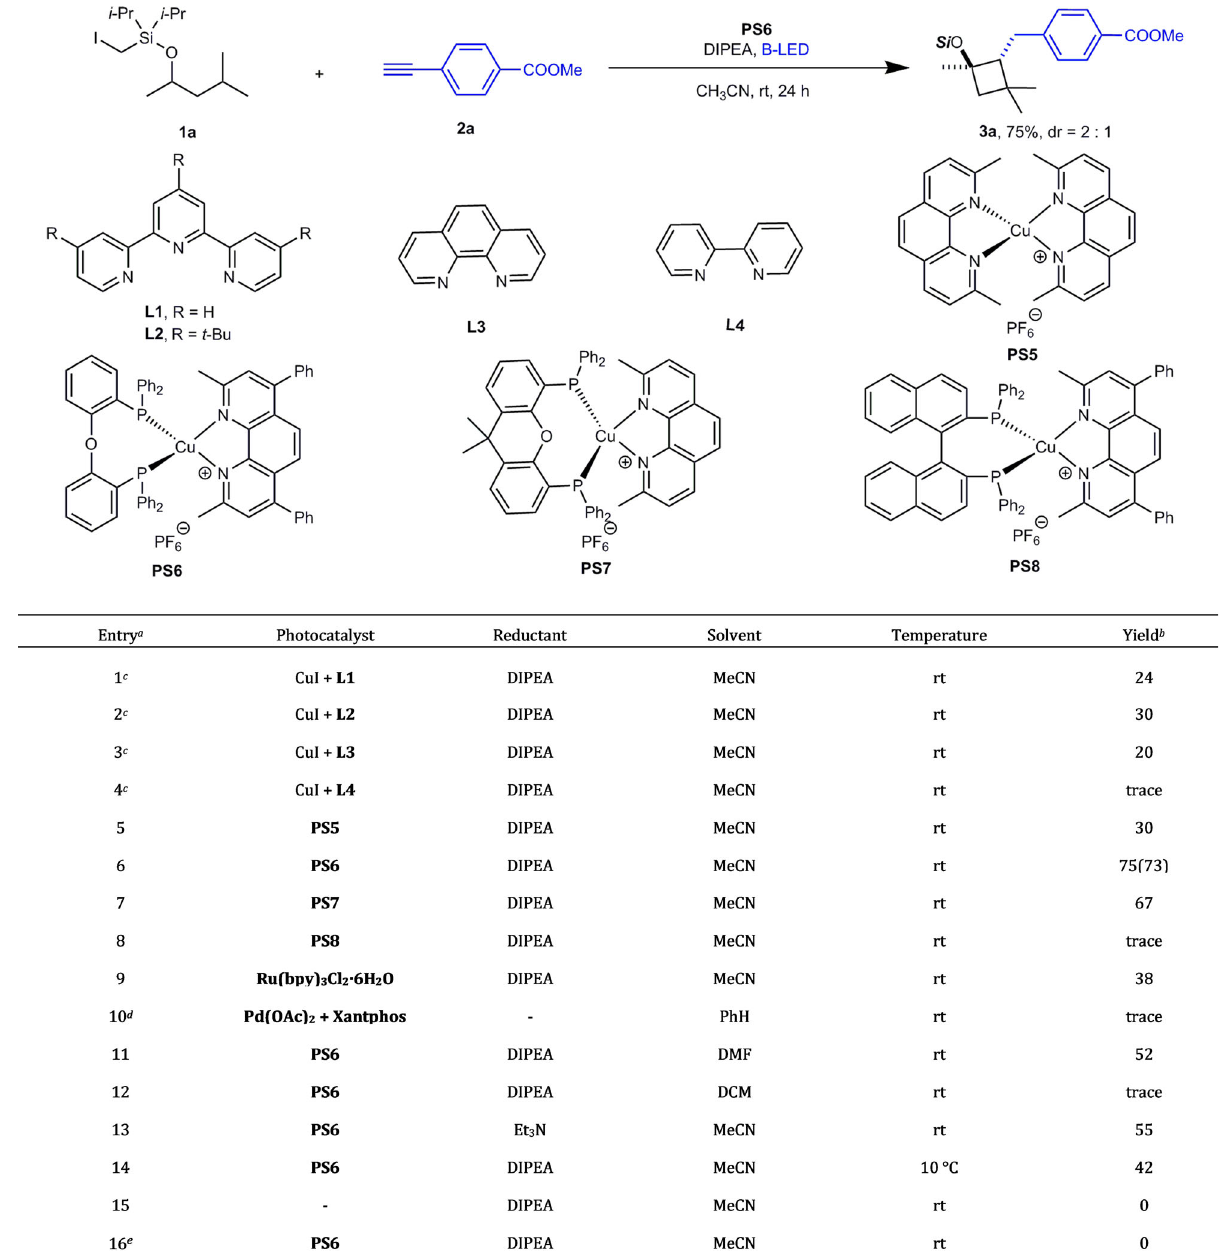
Fig. 2 Synthesis of 3a under various reaction conditions. a 1a (0.1 mmol), 2a (0.15 mmol), PS (10 mol %), N , N -Diisopropylethylamine(DIPEA) (4 equiv) in MeCN, under N 2 , rt, B-LED, 24 h. The relative con fi guration was assigned by NOE analysis. b Determined by 1 H NMR analysis with an internal standard (diethyl phthalate). The value in parentheses is the deprotected isolated yield. c CuI (10 mol%), ligand (20 mol %). d Pd(OAc) 2 (10 mol %), Xantphos (20 mol %) and Cs 2 CO 3 (2 equiv) in PhH, under N 2 , rt, B-LED, 24 h. e No